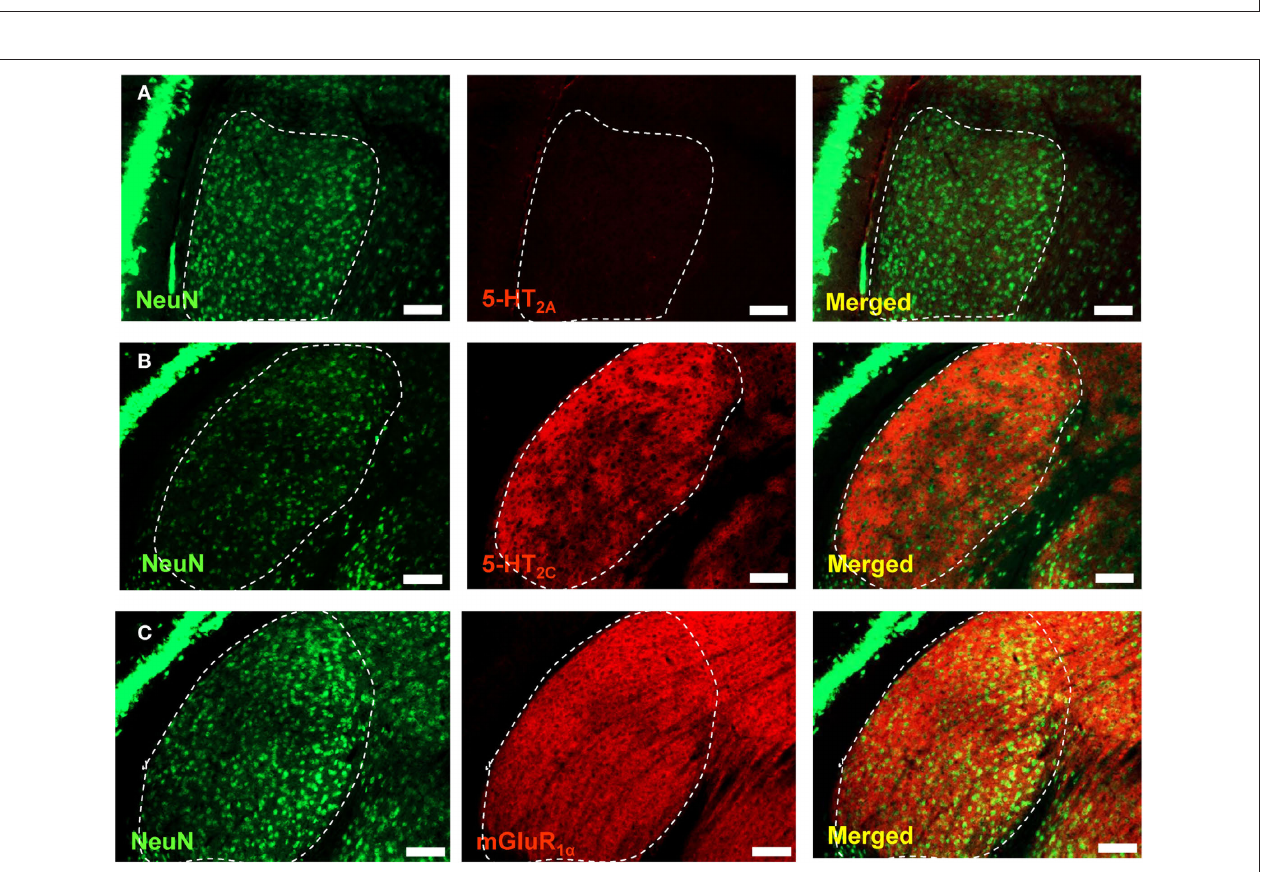
FiGure S2 | immunohistochemical detection of mGlur and 5-HTr subtypes in dLGN of G α same as in Figure 4 .